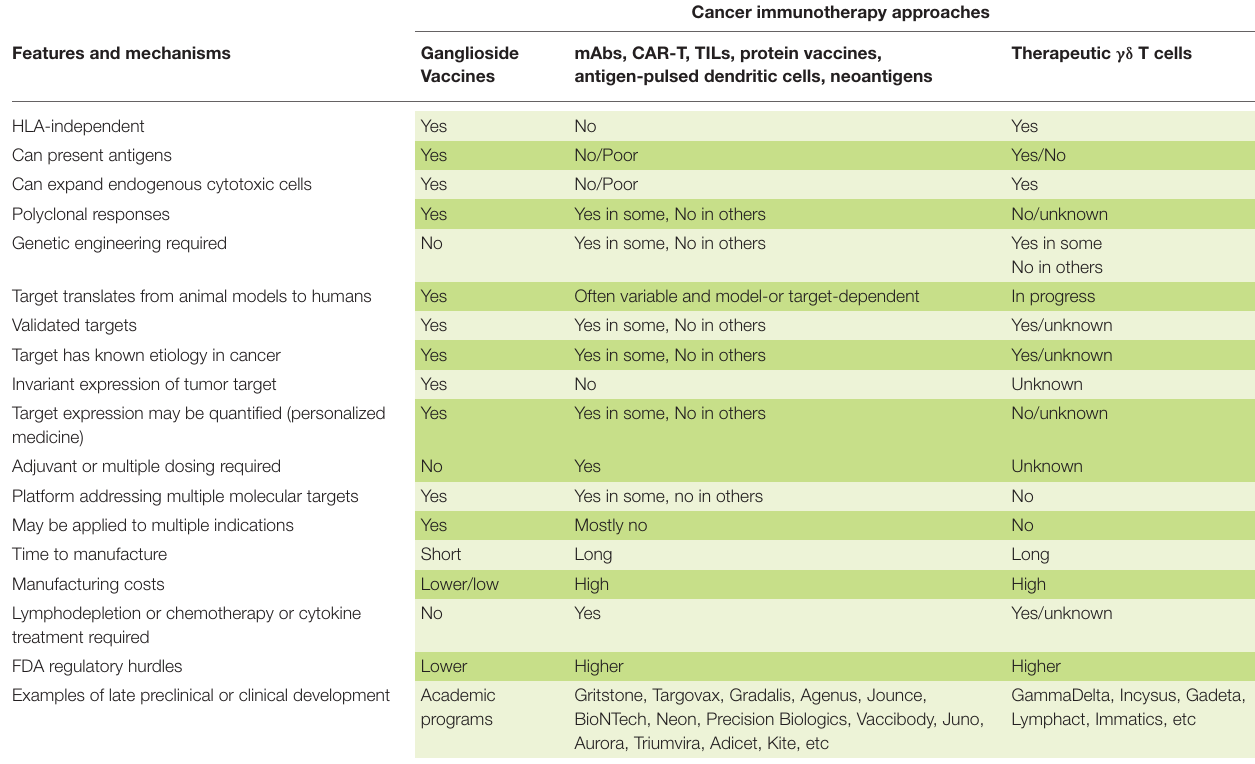
TABLE 2 | Immunotherapeutic approaches involving γδ T cells or γδ